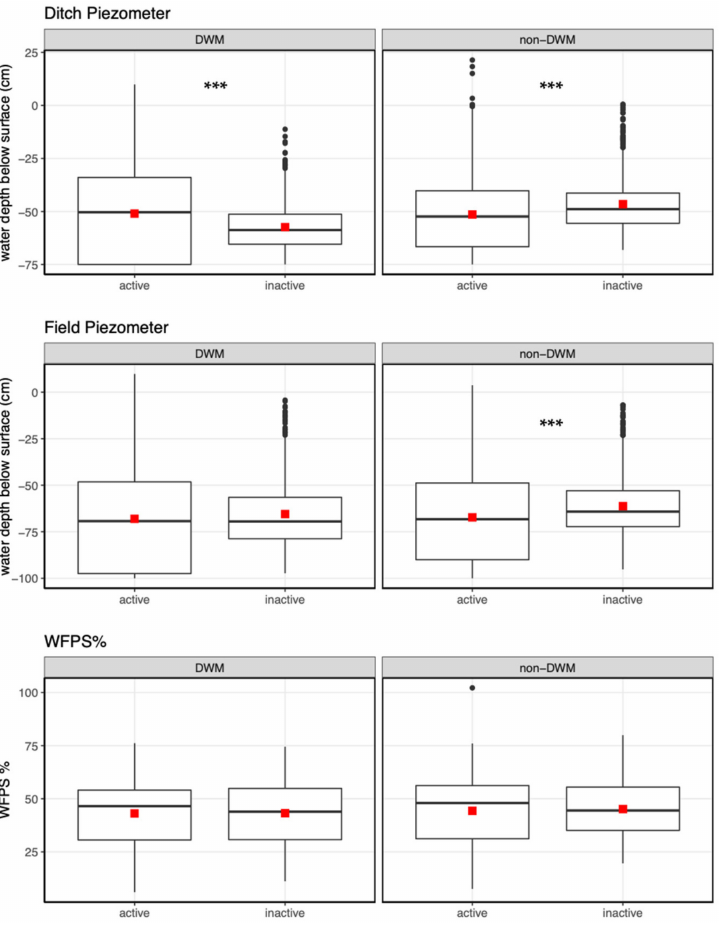
Figure 4. Box plot of the ditch piezometer, field piezometer and %WFPS in surface soil. Data were aggregated by treatment and board period. Asterisks indicate the significance of a Wilcoxon rank sum test for comparison between active DCS versus inactive DCS periods within each treatment (*** indicate p < 0.001; no asterisks indicate p > 0.05). Red squares represent